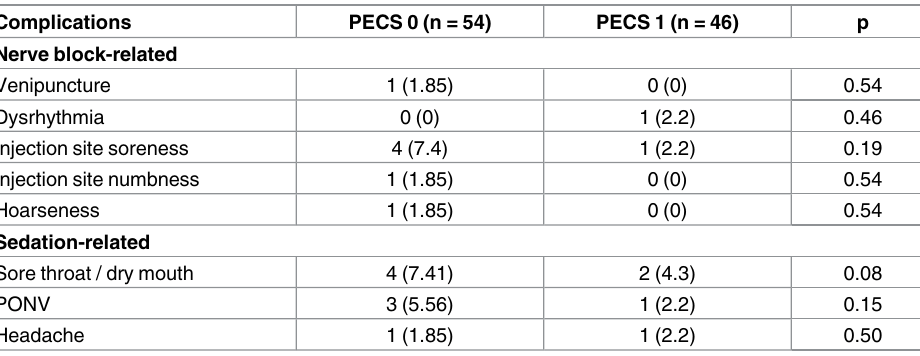
Table 3. Complications.